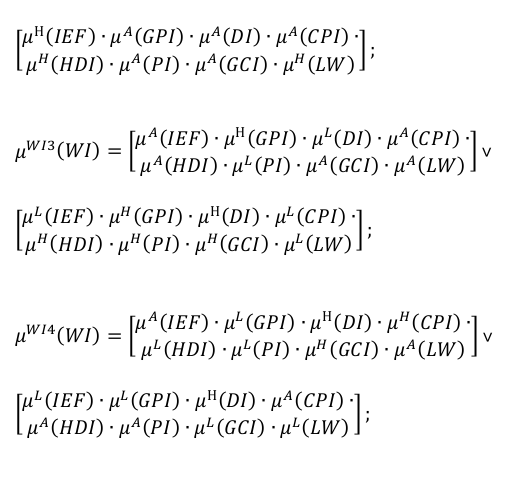
Values of parameters b and c of the membership function of the variables b